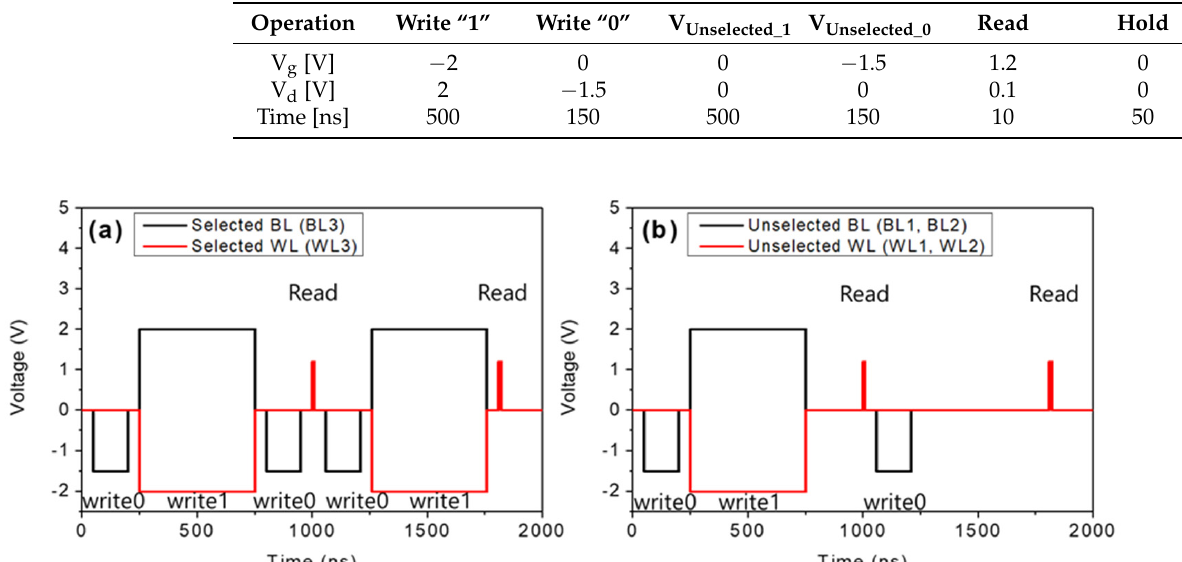
Figure 3. Array circuit structure and cell names used in first simulation. Table 2. Bias and time conditions for transient operation of first simulation.